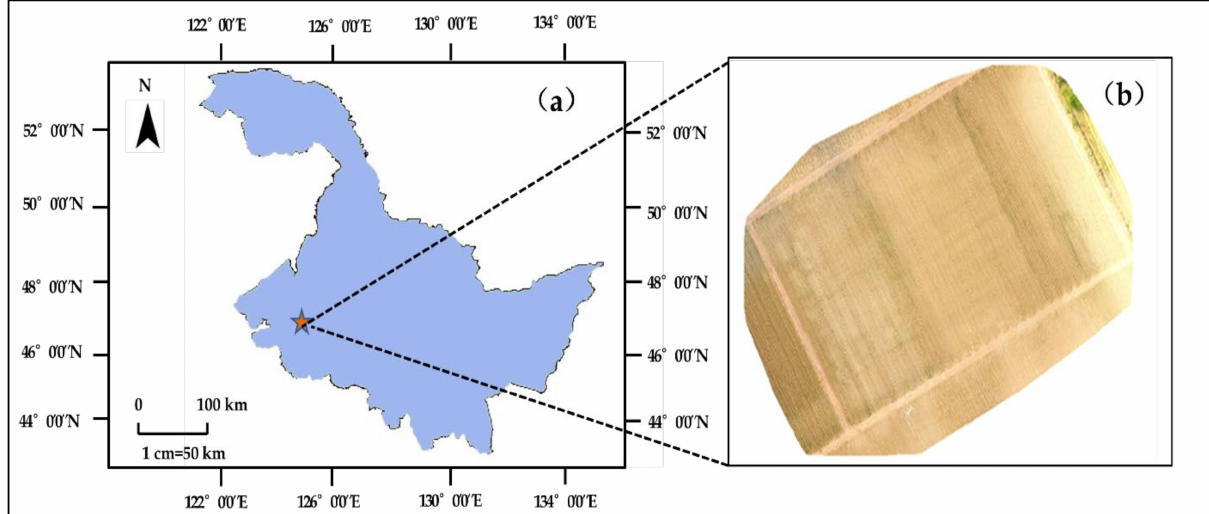
Figure 1. Study area: ( a ) experimental-area location; ( b ) splicing diagram of test